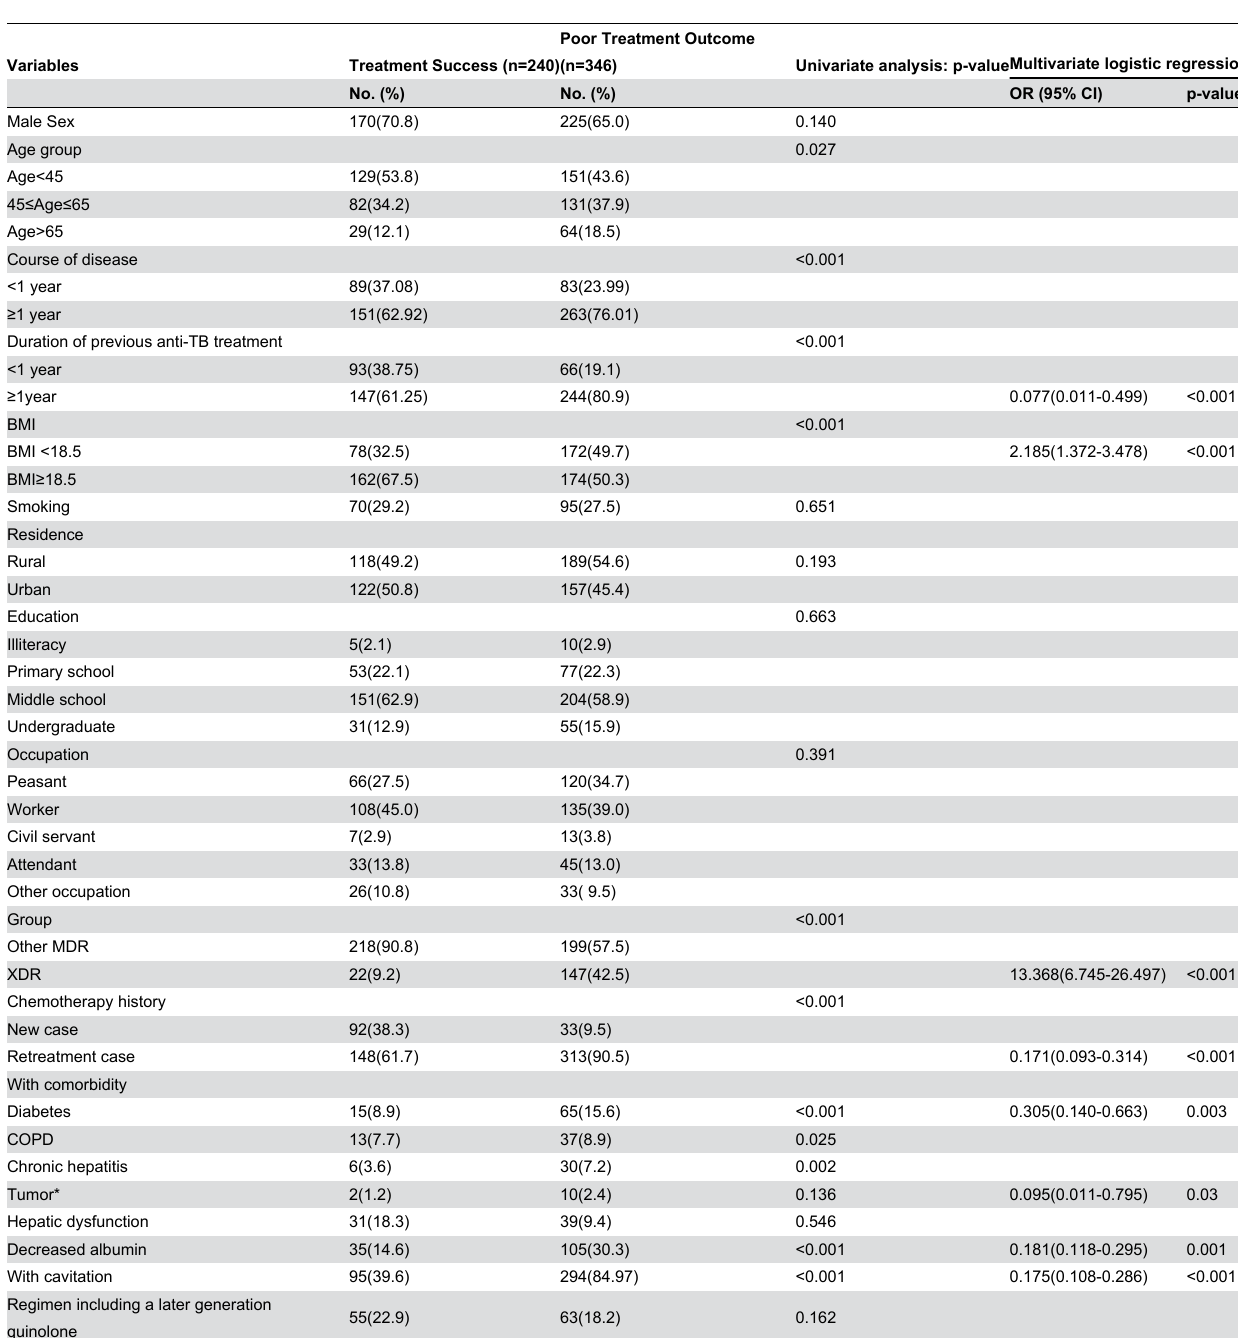
Table 5. Predictors of Poor Treatment Outcomes for 586 patients with MDR-TB.